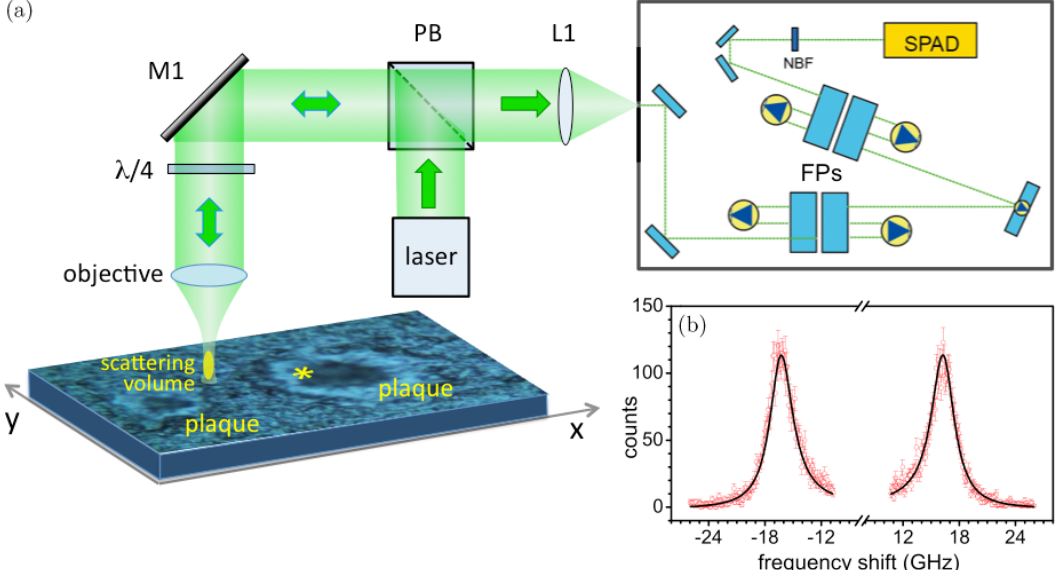
Fig. 1. (a) Schematic of the micro-Brillouin experiment conducted on a TASTPM mouse brain hippocampal section containing two A (cid:1) plaques. (Photomicrograph was obtained using a Renishaw inVia Raman microscope with 20 (cid:1) objective.) M1: mirror; PB: polarizing beam splitter; L1: lens; FPs: Fabry-Perot interferometers; NBF: narrow bandpass ¯lter; SPAD: single photon avalanche photodiode. (b) Micro-Brillouin spectrum extracted from the scattering volume indicated by an asterisk in (a). Results from ¯t analysis to a damped harmonic oscillator function are shown (peak position: 16